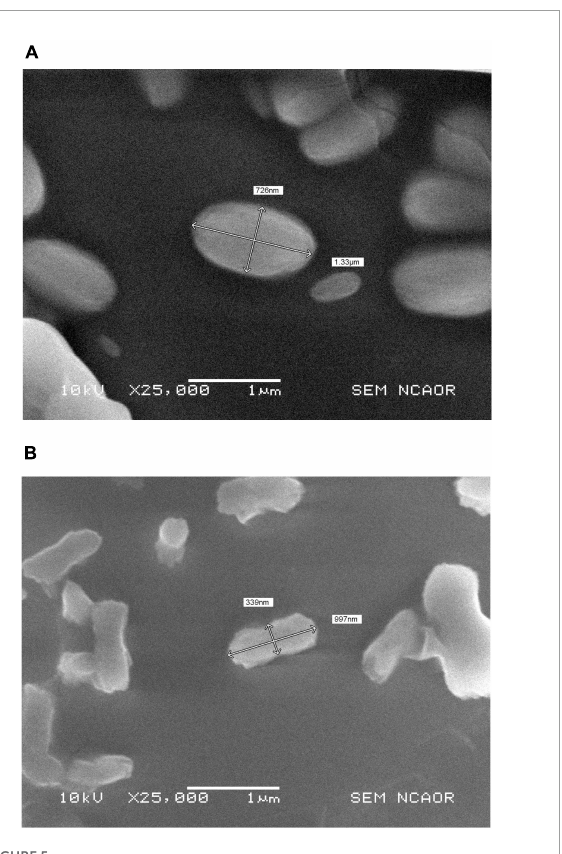
FIGURE5 (A) SEM-photomicrographs showing Chromohalobacter sp.